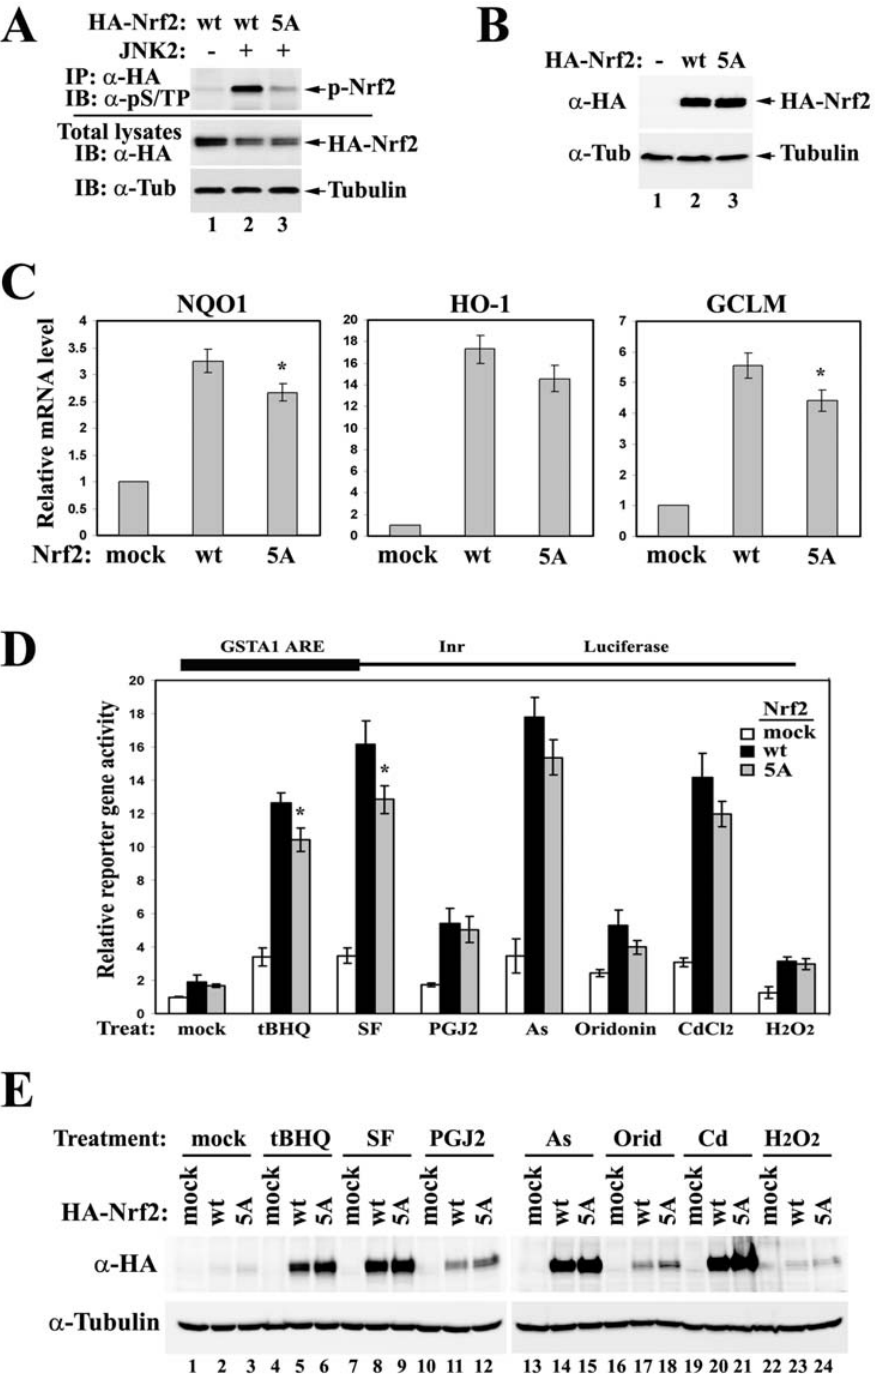
Figure 3. Genetic disruption of Nrf2 phosphorylation slightly attenuates Nrf2 activities without affecting its protein levels. (A) HEK293T cells were cotransfected with expression vectors for HA-tagged Nrf2 and JNK2. Cell lysates were immunoprecipitated with anti-HA antibodies. The immunoprecipitated protein was analyzed by immunoblot with antibodies specific for phosphorylated serine or threonine residue adjacent to a proline (pS/TP) (Abcam ab9344). wt: wild-type; 5A: the mutant with combined alanine substitution on all five phosphorylation sites. (B– C) HEK293T cells overexpressing either Nrf2-WT or Nrf2-5A were subjected to immunoblot (B) and qRT-PCR analysis (C). The error bars indicate the standard deviations calculated from triplicate samples. * p , 0.05 when compared to wt. (D) MDA-MB-231 cells were cotransfected with expression vectors for the GSTA1-ARE-dependent luciferase reporter gene, Keap1, and the indicated Nrf2. Cells were treated with several Nrf2 inducers for 16 hrs prior to reporter gene analysis. tBHQ: tert-butylhydroquinone (50 m M); SF: sulforaphane (20 m M); PGJ2: 15-Deoxy- D -12,14-prostaglandin J2 (10 m M); As: sodium arsnite (20 m M); Orid: Oridonin (10 m M); Cd: cadmium chloride (20 m M); H 2 O 2 : hydrogen peroxide (500 m M). Error bars indicate standard deviations calculated from three independent assays. * p , 0.05 when compared to wt in the same treatment group. (E) Total cell lysates from the above reporter gene assay were analyzed by immunoblot.